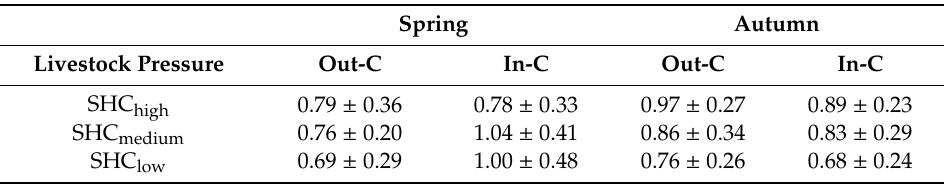
Table A5. Average Shannon’s diversity values ± SD found at each SHC (high, medium and low livestock pressure), in each Location (beneath = in-C and outside the canopy = out-C) during both sampling